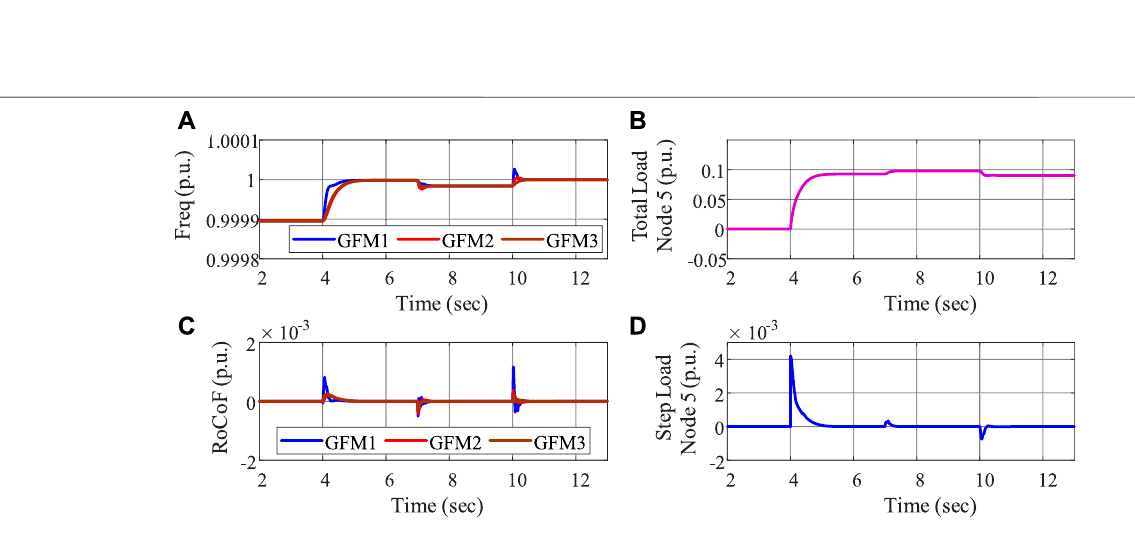
Frontiers in Energy Research |